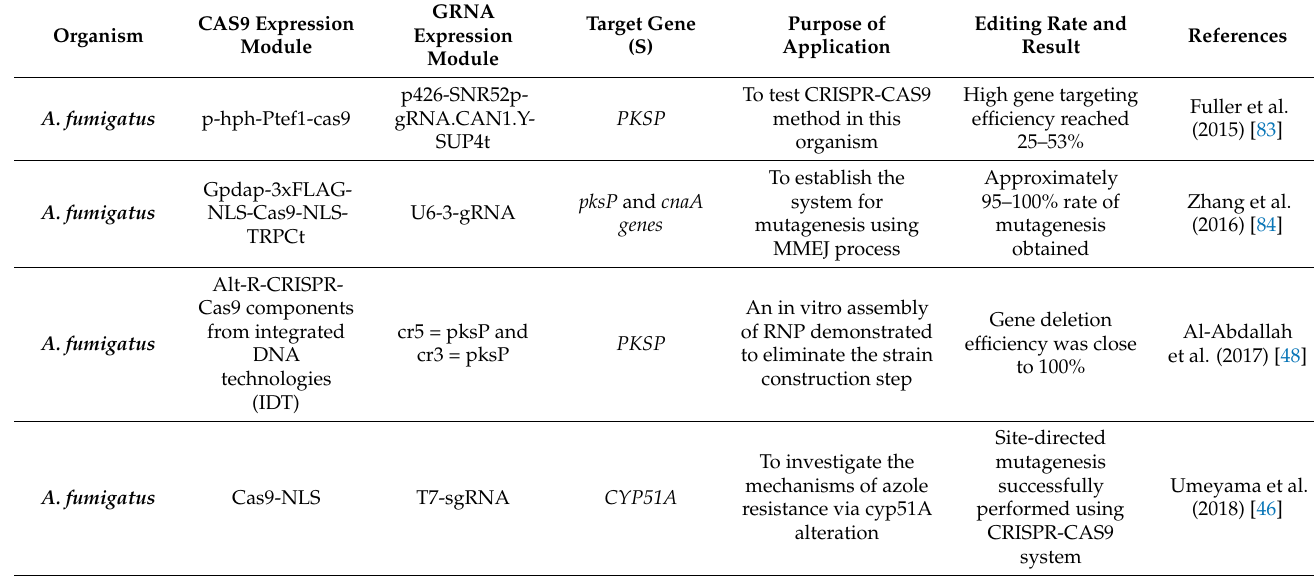
Table 2. Modules, applications and success rate of the CRISPR system in manipulating clinically relevant molds.